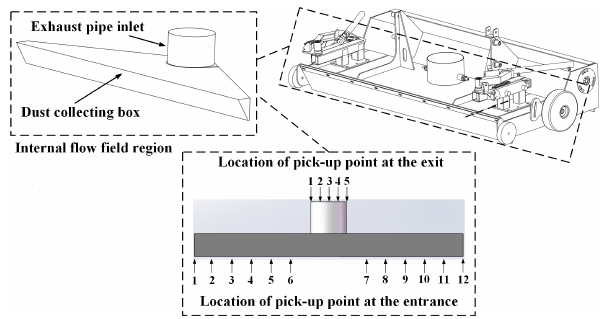
Figure 7. Location of measurement pick-up